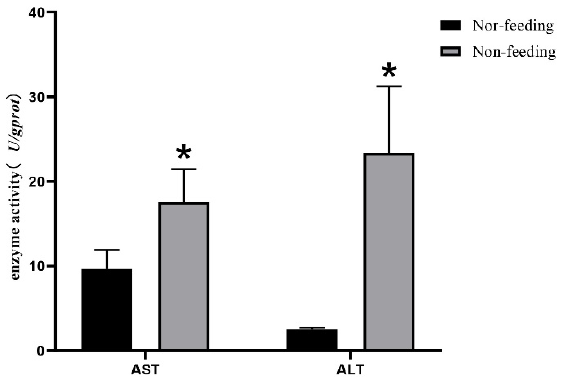
Figure 2. Activity of aspartate aminotransferase and alanine transaminase in liver. Nor-feeding: successful weaning; non-feeding: failed weaning. * p < 0.05.